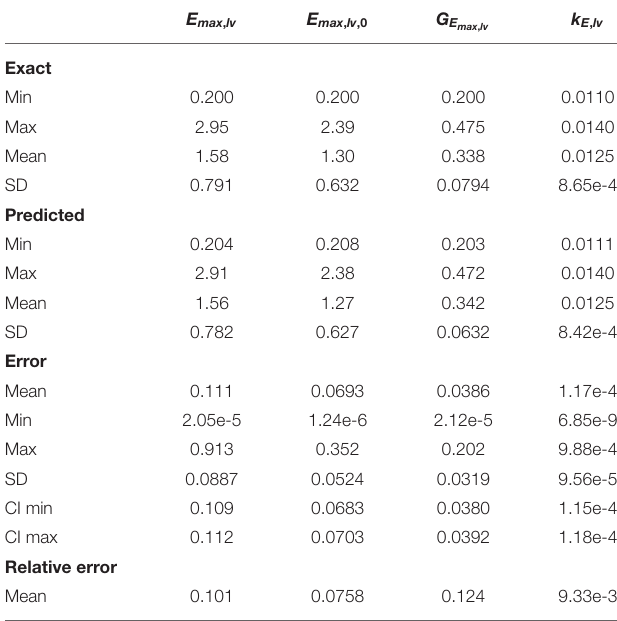
TABLE 1 | Evaluation of the DNN performance on the test set, by comparing exact and predicted parameters of the output of the